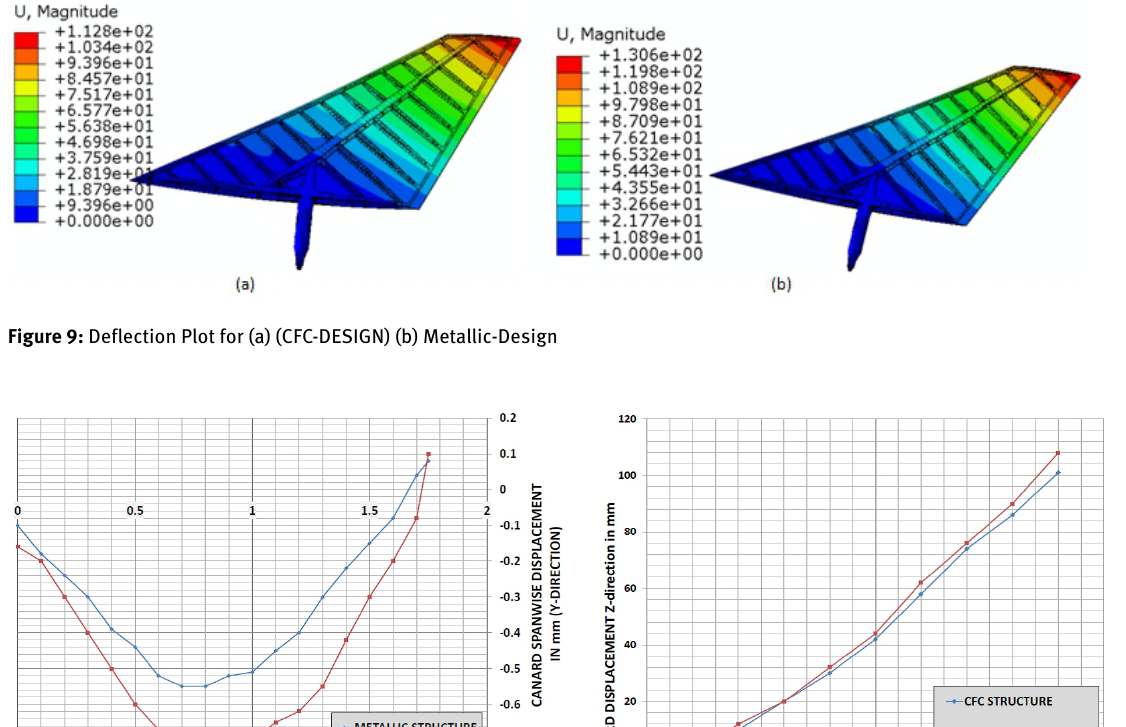
GA to the laminate layup problem is viable. The GA used to optimize the ply-orientations shows a fast convergence and came out with better near optimal